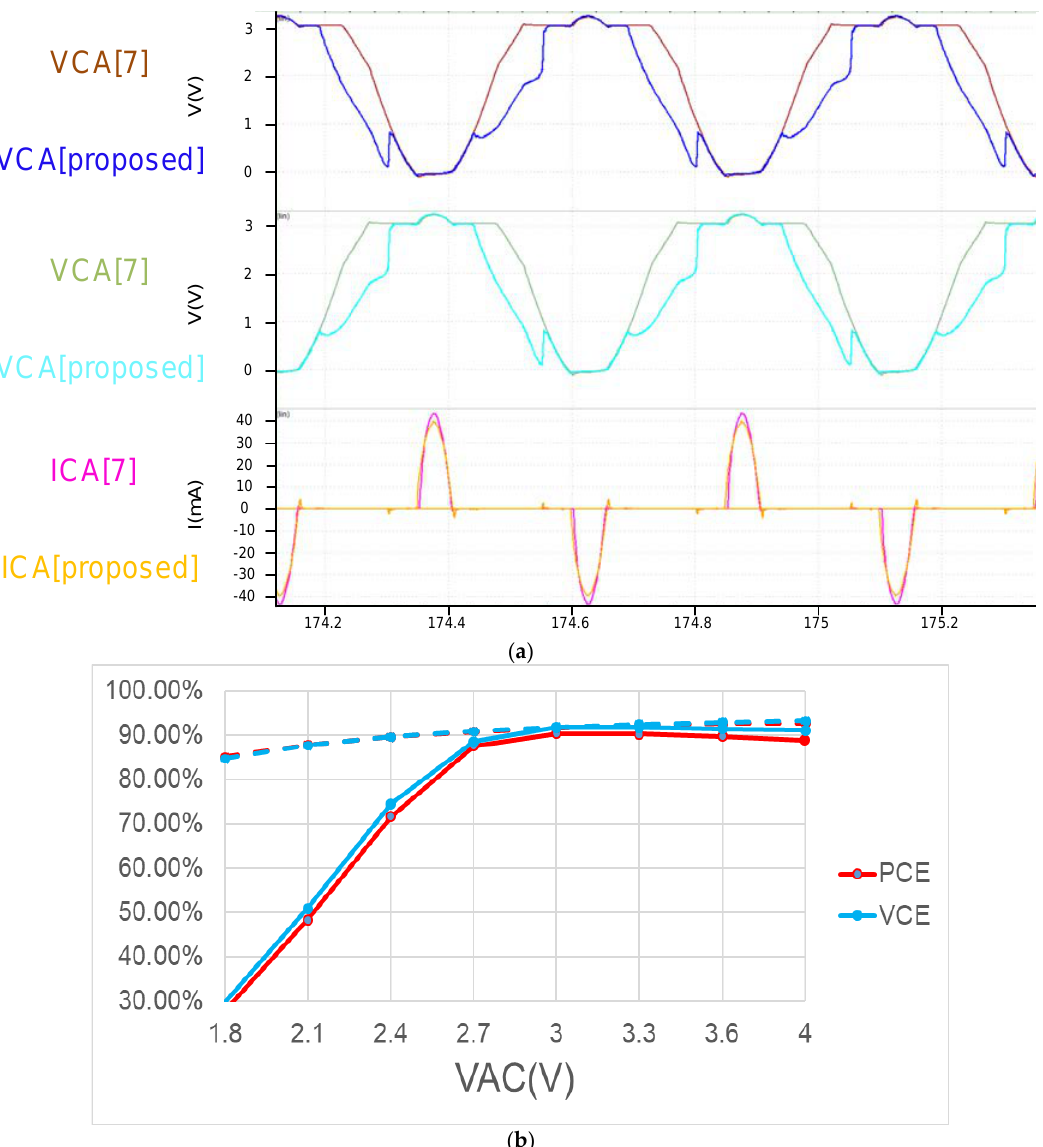
Figure 17. ( a ) Simulation result of comparing [proposed] and [10] ( b ) Compare [proposed] and [7] PCE VCE (solid is proposed circuit dot is [10]) [7] PMOS size is twice that of the upper half of NMOS, operating at 2 MHz with R L = 500 Ω